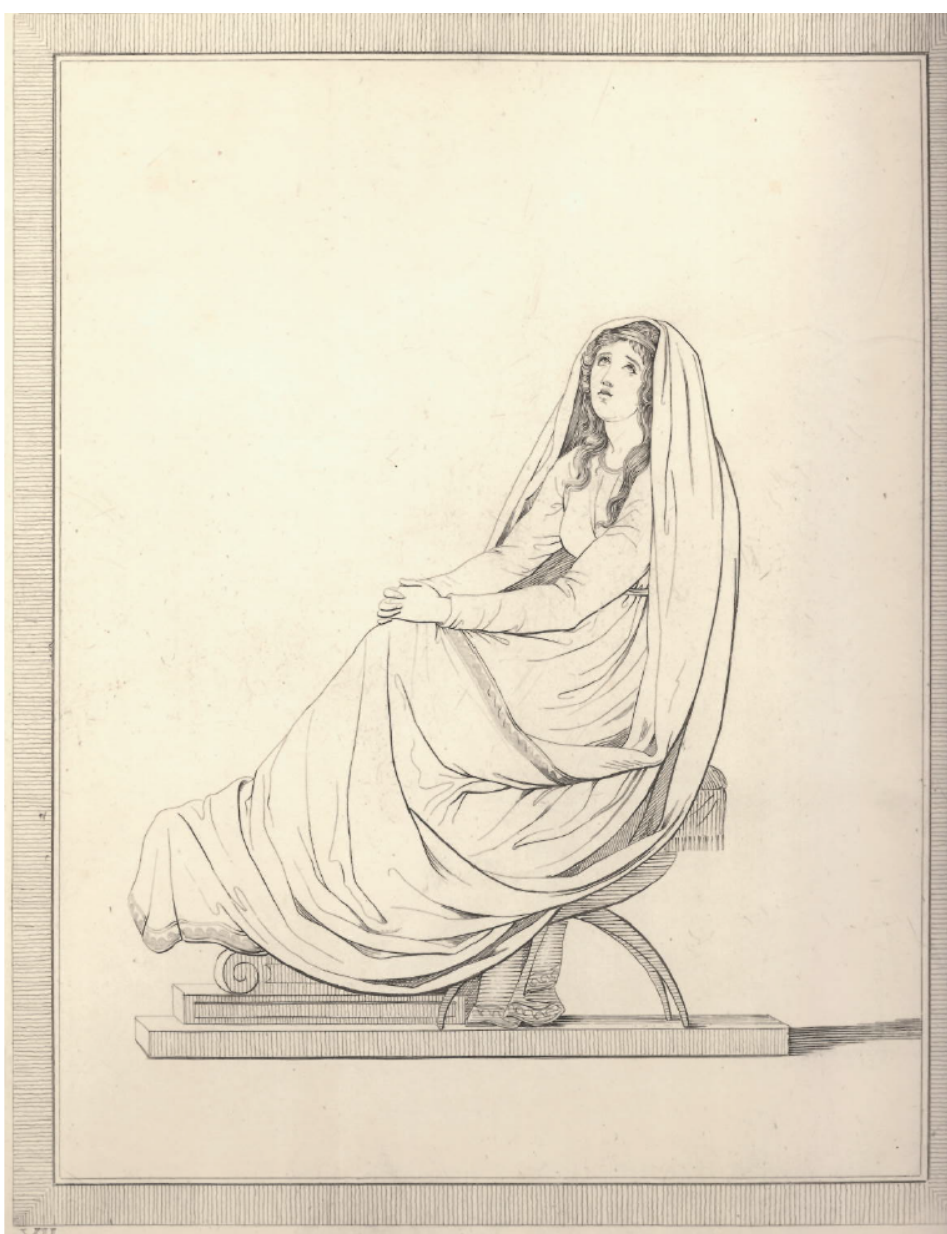
Figure 6 Lady Hamilton’s “attitudes,” from Friedrich Rehberg, Drawings Faithfully copied from Nature at Naples (London: S.W. Fores, 1797), unpag. (photo: